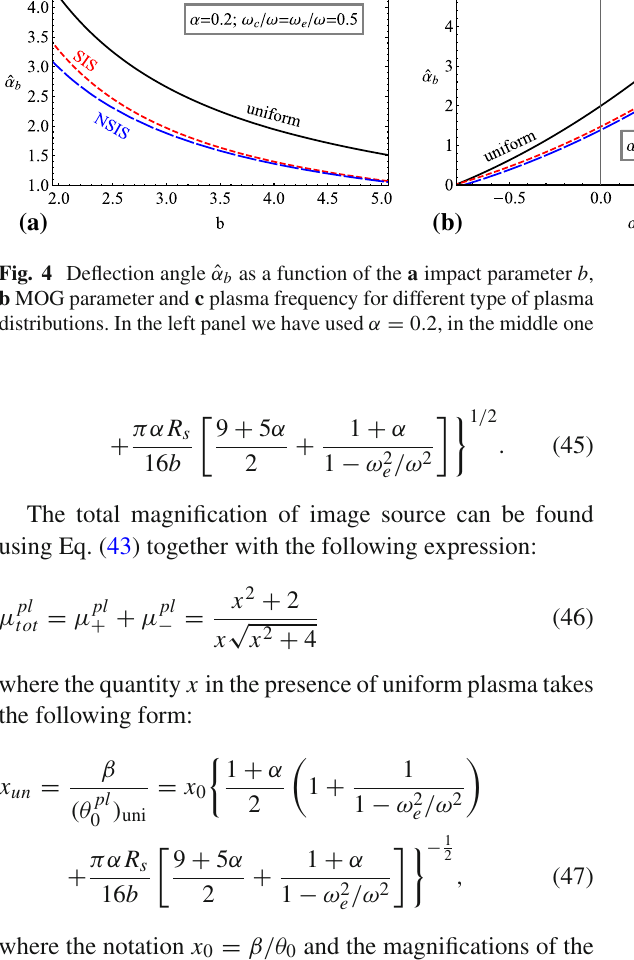
Figure 5 illustrates the effect of the MOG parameter on the total magnification with the comparison of the absence and presence of the uniform plasma medium cases with the parameter ω c /ω = 0 . 3 , 0 . 5. One can see that the magnifica- tion increases (quasi)linearly with the increase of the MOG parameter and plasma